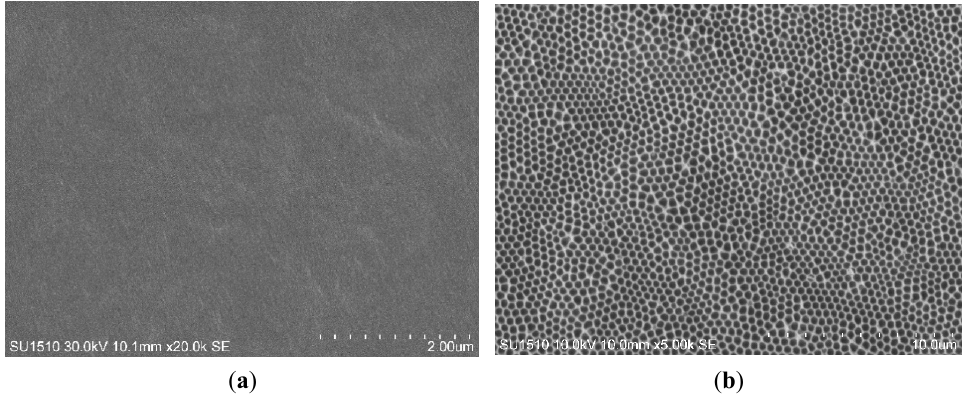
Figure 1. SEM images of noble metal fi lms a tt ached to pretreated silicon wafers: ( a ) Ag nanoparticles formed on the surface of the silicon substrate (HF + AgNO 3 = 4.8 mol/L + 0.005 mol/L; silver-plating time: 120 s) [22]; ( b ) ordered nanomesh-pa tt erned Au fi lms formed on the surface of the silicon substrate (spu tt ering current: 3 mA; spu tt ering time: 110 s; the number of spu tt ering applications: two; thickness of Au fi lm: 14.55 nm) [17].